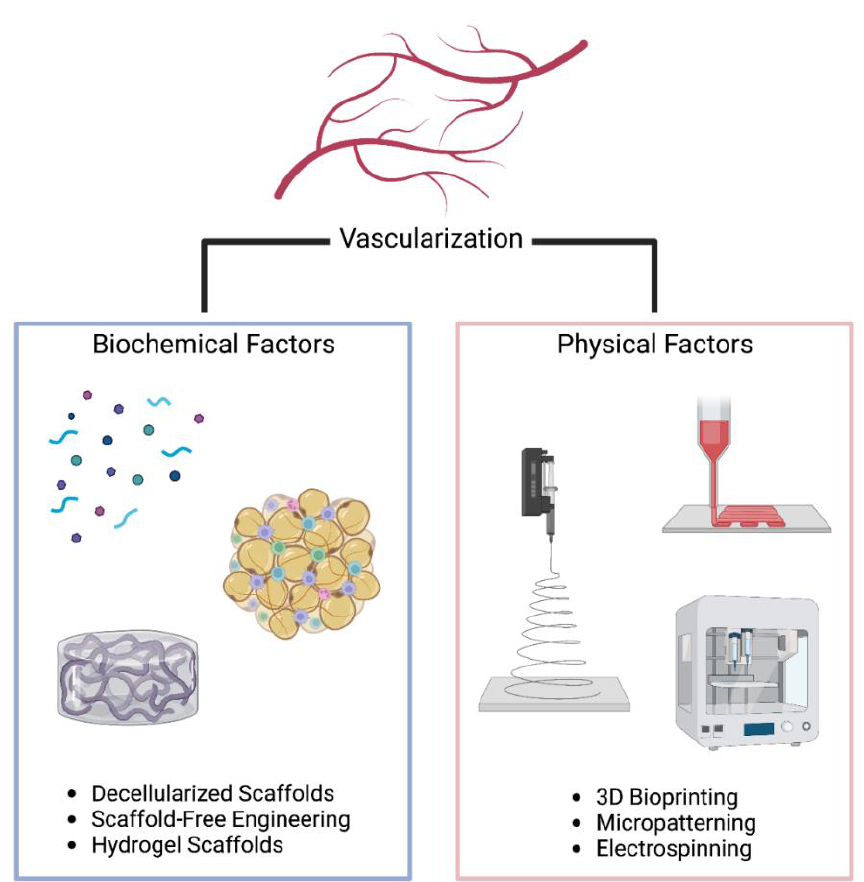
Figure 1. Overview of vascularization strategies using biochemical and biophysical factors.